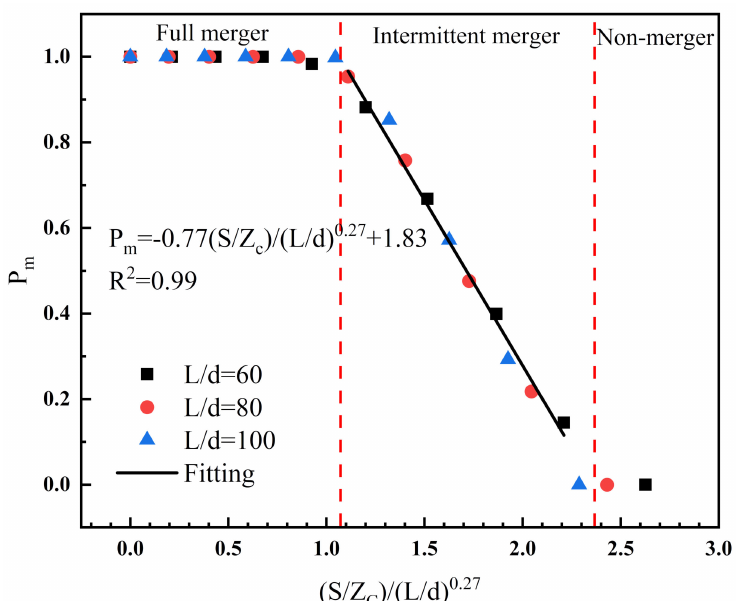
Figure 10. Relationship between P m and dimensionless characteristic parameter (S/Z C )/(L/d) 0.27